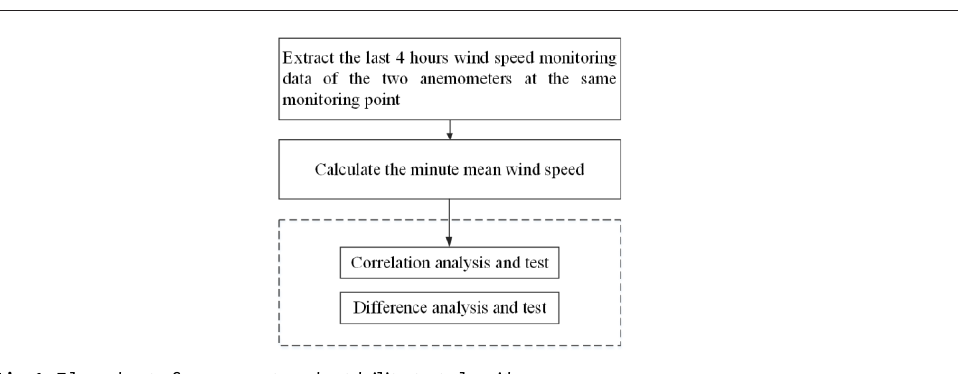
Fig. 1. Flow chart of anemometer adaptability test